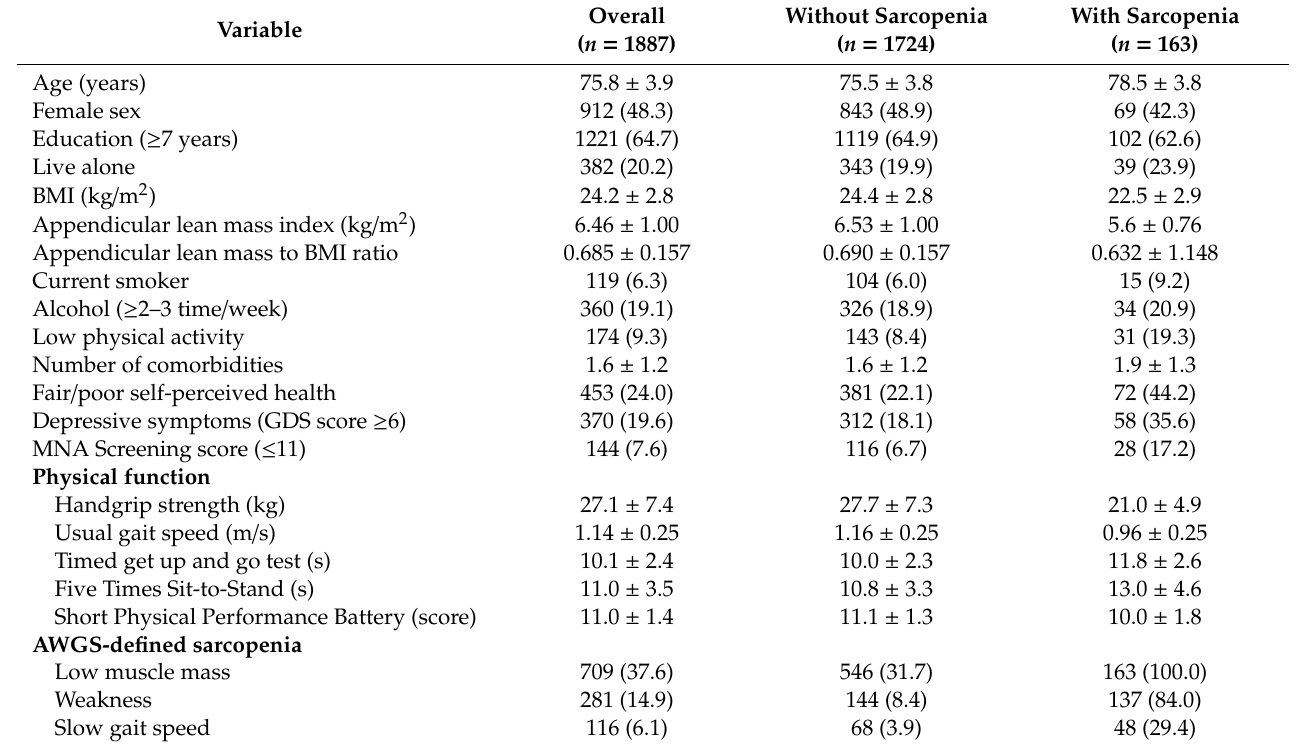
Table 1. Demographic characteristics of participants with and without sarcopenia by AWGS